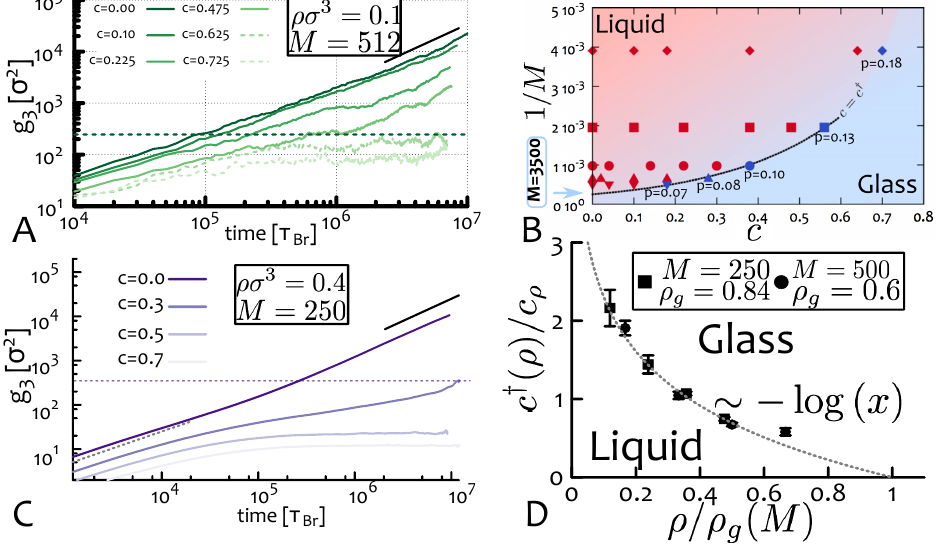
Figure 8. ( A ) Transition from liquid to glassy behaviour as a function of increasing pinned fraction c and for a system of rings with M = 512 and ρ = 0.1 σ − 3 . for which we find c † (cid:39) 0.6. ( B ) Phase diagram of the system in the parameter space ( c ,1/ M ) . The “critical” line M † ( M ) = M g exp ( − c / c M ) separates regions with finite (liquid, red region and symbols) and vanishing (glassy, blue region and symbols) diffusion coefficients. The values of p along the transition line represent the probability of finding an uncaged ring in any one system replica as computed through a binomial distribution at 95% confidence interval, i.e., ( 1 − p ) ( 1 − c † ) N = 0.05. ( C ) Transition from liquid to glassy behaviour as a function of increasing pinned fraction c for system of rings with M = 250 and ρ = 0.4 σ − 3 . In this case we find c † ( ρ ) (cid:39) 0.32. ( D ) Phase diagram of the system in the parameter space ( ρ , c ) . Rescaling the values of c † by a constant c ρ (cid:39) 0.43 and ρ by ρ g ( M ) we find a collapse of the data points onto a master curve c † / c ρ = − log (see Equations (6) and (7)